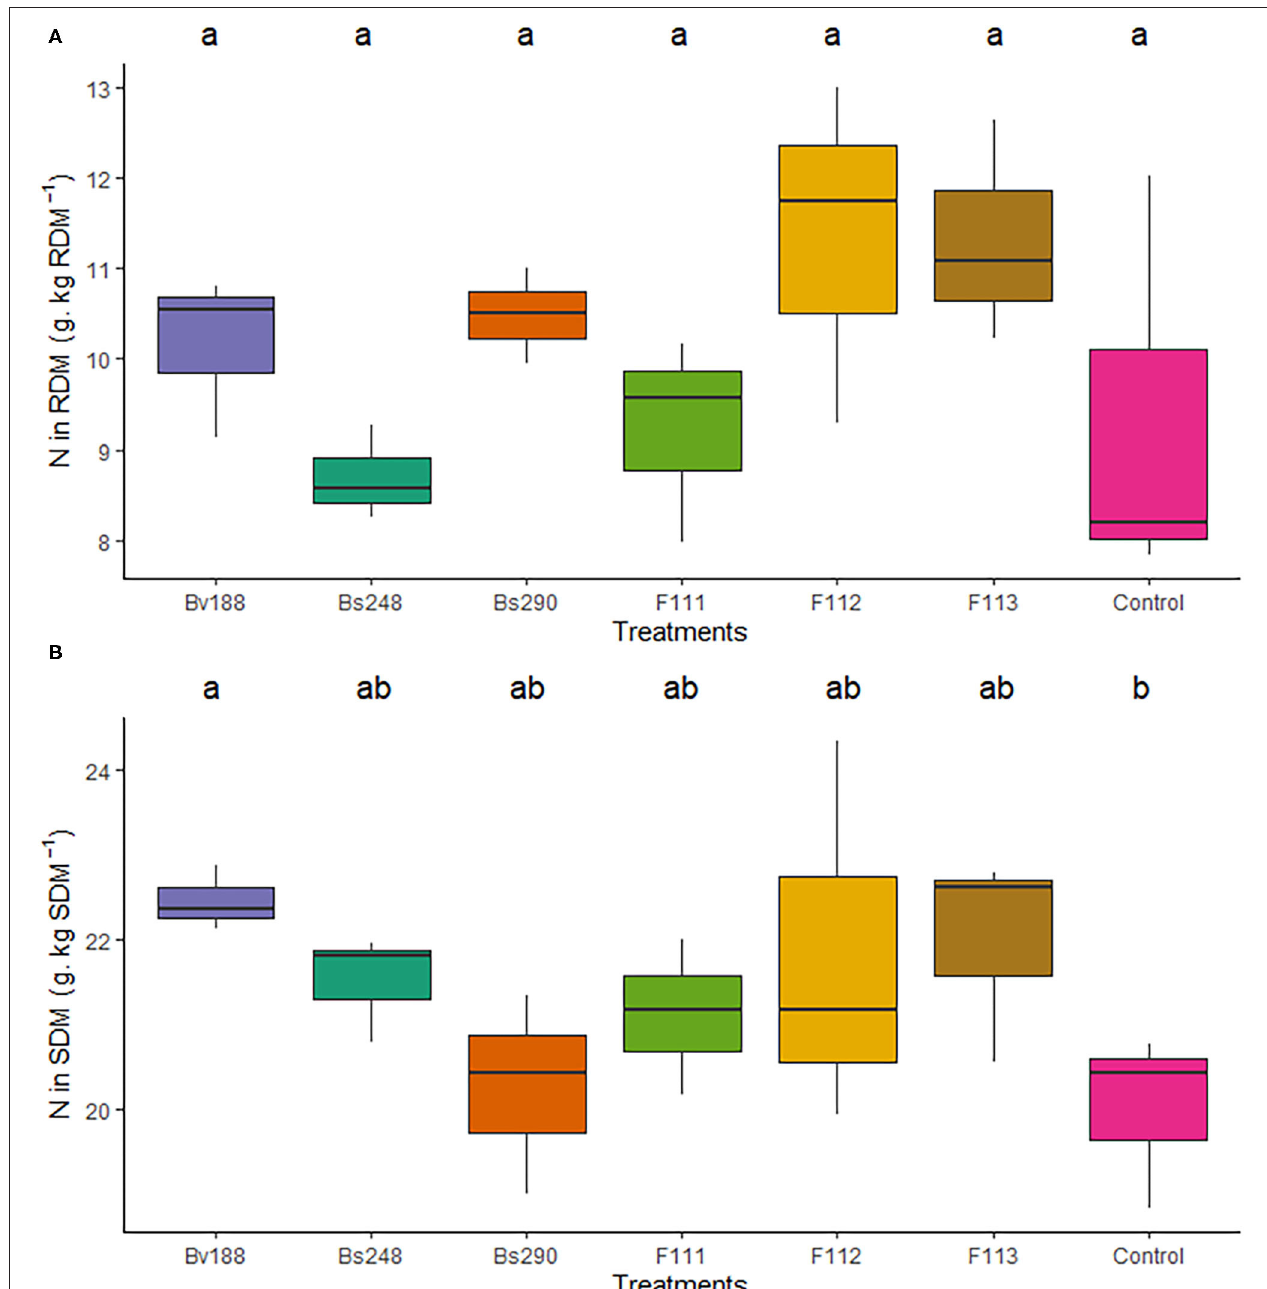
FIGURE 4 | Boxplots (median and quartiles) of the N content in the root (A) and shoot (B) dry matter of cotton plants inoculated with the treatments. Different letters in the rows indicate significant differences between means (Duncan’s, p < 0.05). RDM, root dry matter; SDM, shoot dry matter; Bv188, Bacillus velezensis strain Bv188; Bs248, Bacillus subtilis strain Bs248; Bs290, B. subtilis strain Bs290; F111, Aspergillus brasiliensis ; F112, Aspergillus sydowii ; F113, Aspergillus sp. versicolor section; Control, no